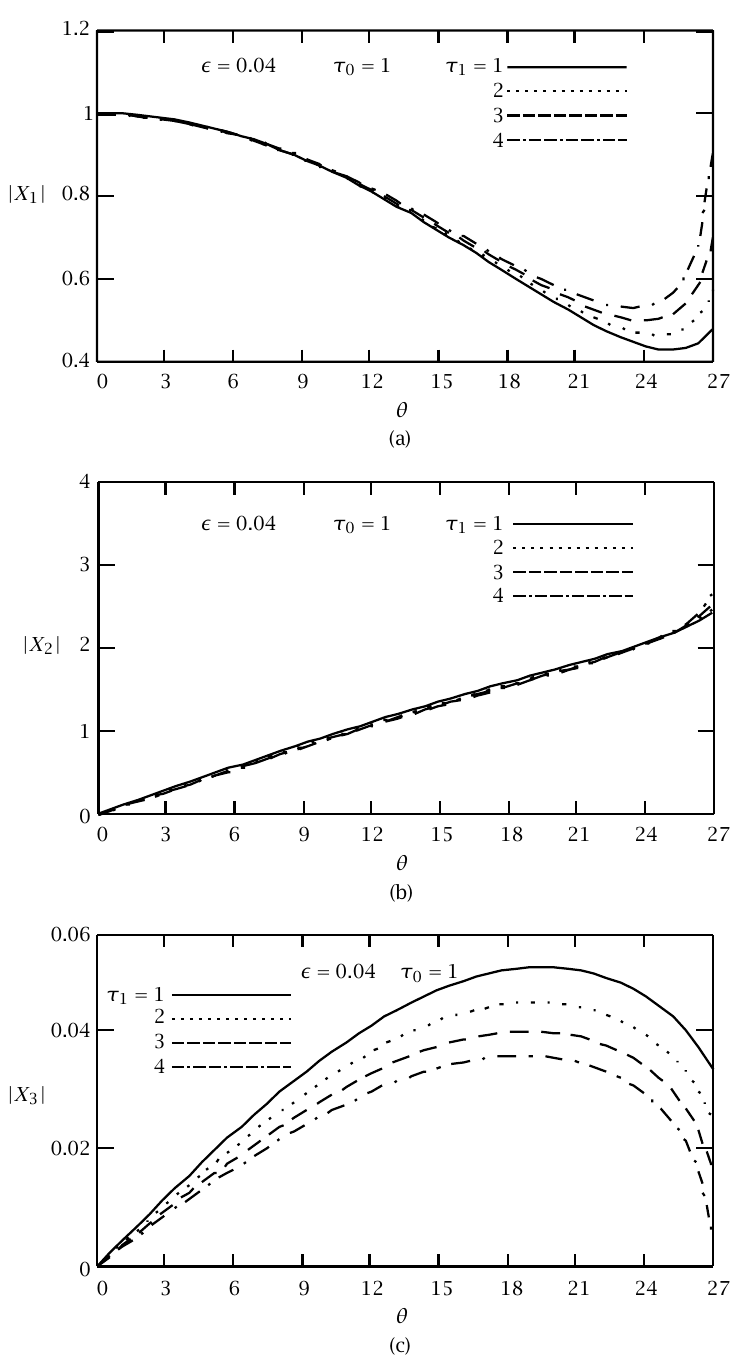
Figure 2 . (The effect of the thermal relaxation times in G-L theory) | X 1 | , | X 2 | , | X 3 | versus the angle of incidence θ